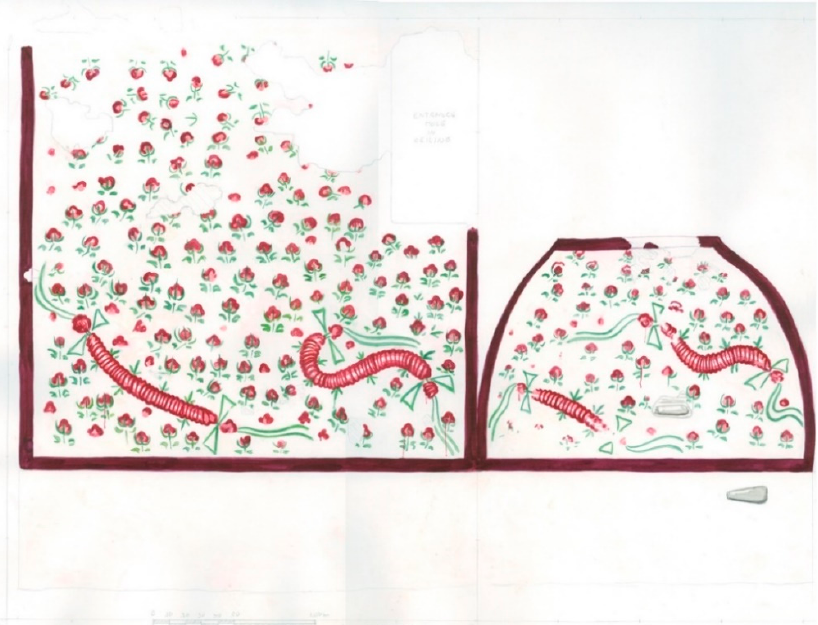
Figure A6. Sardis, Tomb 07.2 (Appendix A.5), drawing of north and east walls. © Archaeological Exploration of Sardis/President and fellows of Harvard College.